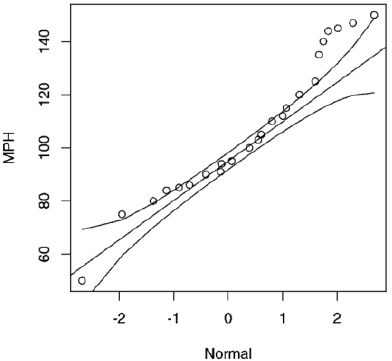
Figure 2. Q-Q Plot for dispersion for a given data regarding a normal distribution.